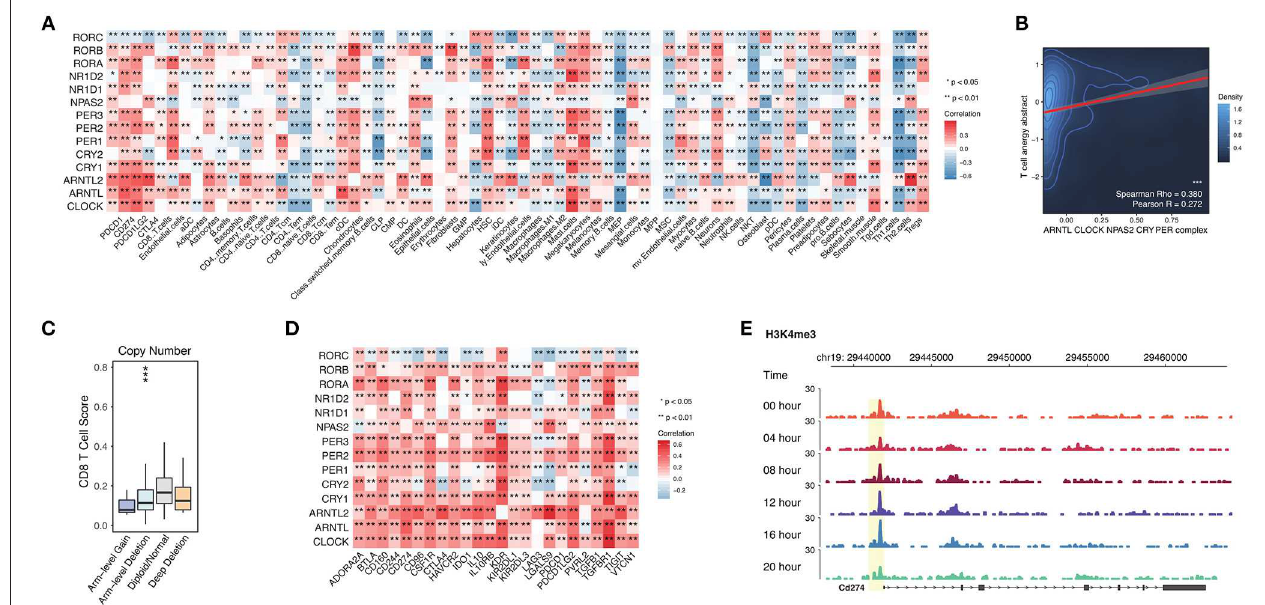
FIGURE 5 | Abnormal circadian clock contributes to T cell anergy and upregulation of immune checkpoint molecules. (A) Core circadian clock genes widely link with infiltrated immune cells and stroma cells in cancers. (B) Circadian clock associates with T cell anergy. T cell anergy and the circadian clock complex were quantified by PARADIGM (Methods). (C) Deletion of PER1 contributes to the reduced CD8T cell infiltration level in stomach adenocarcinoma. (D) Circadian clock genes are positively correlated with immune inhibitory molecules. (E) The promoter activity of PD-L1 (CD274) is controlled by the circadian rhythm.